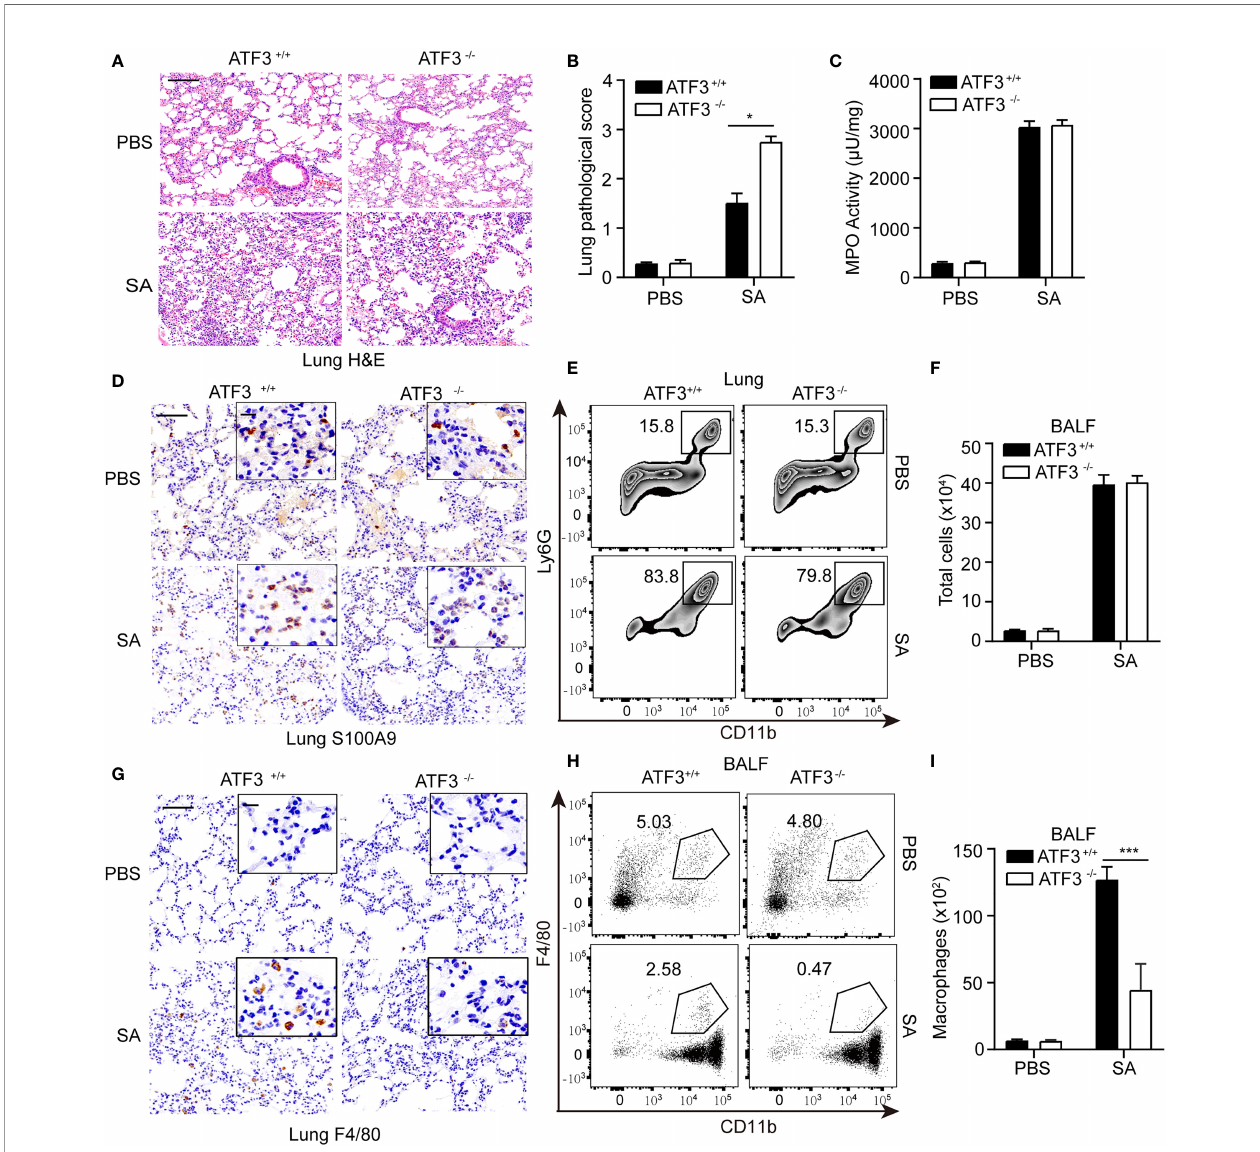
FIGURE 2 | Macrophages confer host protection in WT mice compared with the ATF3 KO. (A) Tissue sections of lung tissues stained with hematoxylin and eosin. (B) Pathological damage scores of lung tissues. (C) Measures of MPO activity as quanti fi ed by ELISA in lung extracts from WT or ATF3 KO mouse after S. aureus infection. (D) Representative images of WT and ATF3 KO mice lung tissues were assessed for neutrophils (S100A9) after S. aureus infection. (E) Representative zebra plot showing CD11b+ Ly6G+ cells from WT or ATF3 KO mice lung tissues after S. aureus infection. (F) Mice BALF was collected; counts of total cells are shown. WT and ATF3 KO mice were infected intratracheally with S. aureus (5 X 10 7 CFU/mouse). After 6h, the mice were euthanized and their BALF was collected, stained and subjected to fl ow cytometry. (G) Representative images of WT and ATF3 KO mice lung tissues were assessed for macrophage (F4/80) after S. aureus infection. (H) Representative dot plot showing CD11b+ F4/80 + cells. (I) Quanti fi cation of (H) Data are shown as the mean ± SD. * P < 0.05; *** P < 0.001 by Student ’ s t